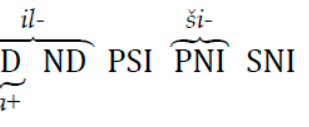
Figure 9. Reference Hierarchy for Levantine varieties. Figure 10. Possible reading for some Levantine varieties.